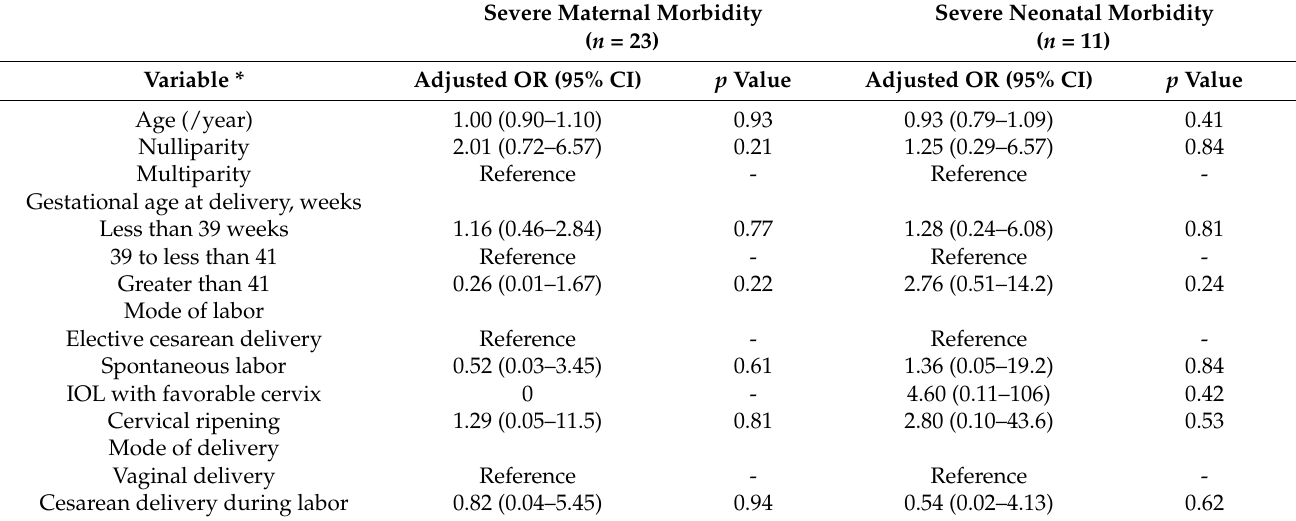
Table 5. Multivariate analysis of severe maternal and neonatal morbidity after planned cesarean delivery or spontaneous or induced labor.